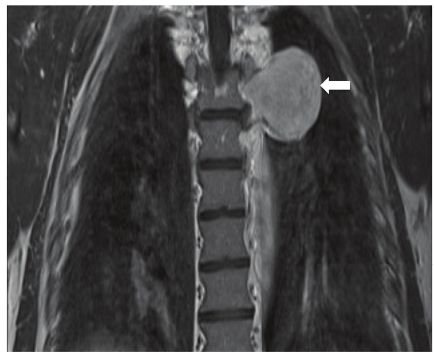
Figure 5: Chest MRI (coronal T1 gradient echo sequence with intravenous gadolinium contrast enhancement) in a 50-year-old male patient with Castleman disease. The left paraspinal pleural- based mass demonstrates homogenous enhancement following in- travenous gadolinium administration